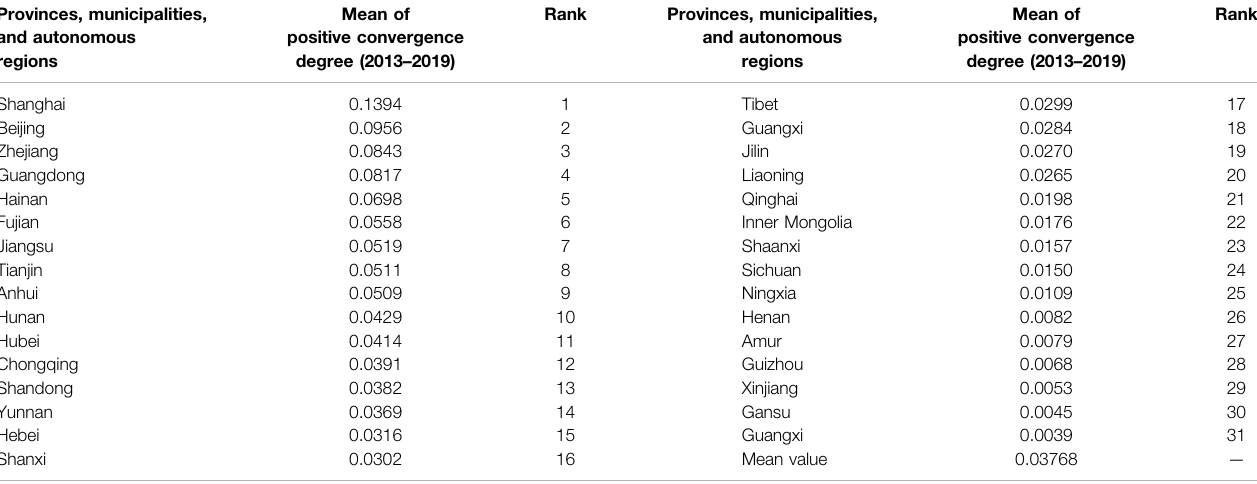
Data source: China Input-Output Table 2012, 2015, and 2017.